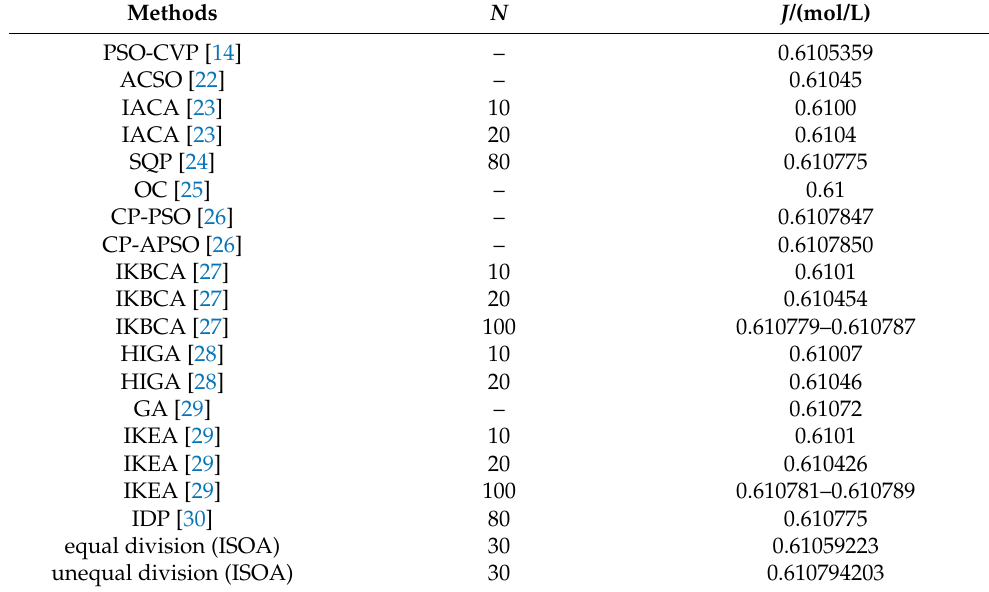
Table 2. Comparison of batch reactor